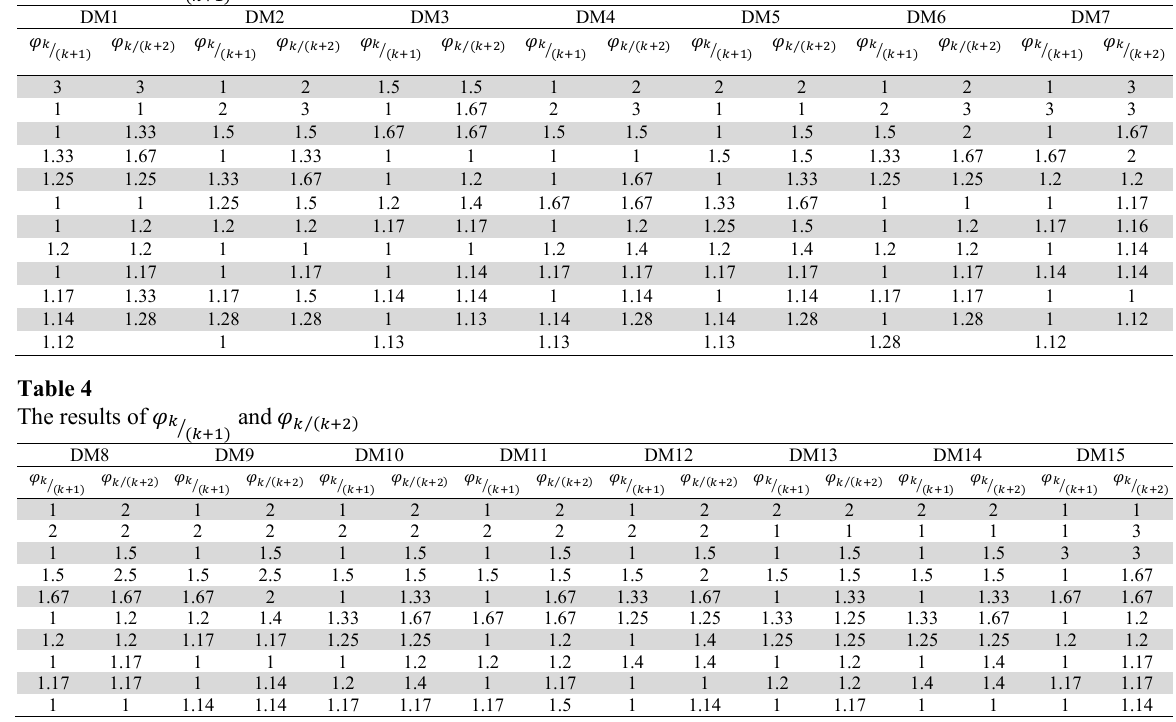
and 𝜑 (cid:3038) ( (cid:3038)(cid:2878)(cid:2870) ) ⁄ ( (cid:3038)(cid:2878)(cid:2869) ) (cid:3415)